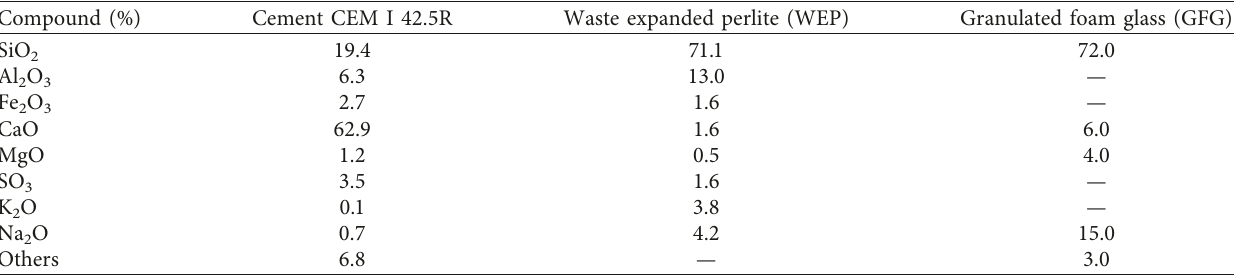
Table 1: Chemical composition of used